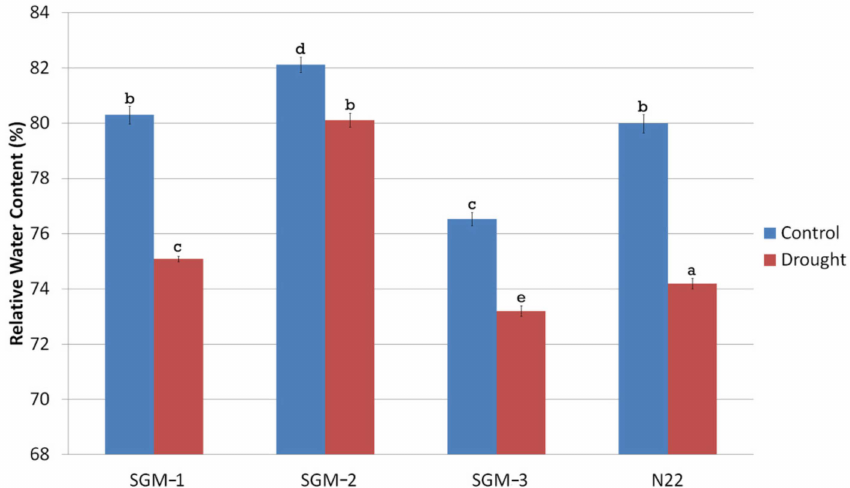
Figure 4. Relative water content (%) of the three stay-green mutants (SGM-1 to SGM-3) and the wild type, Nagina 22 (N22) under well-watered (control) and drought stress conditions (a to e denotes significance at p (0.05) determined from one way ANOVA post hoc Tukey